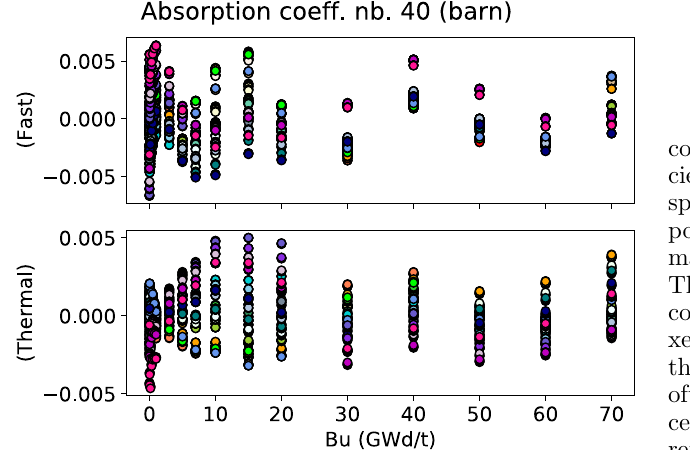
Fig. 7. Scatter plot of coefficient 40 along the burnup axis (UGd dataset).